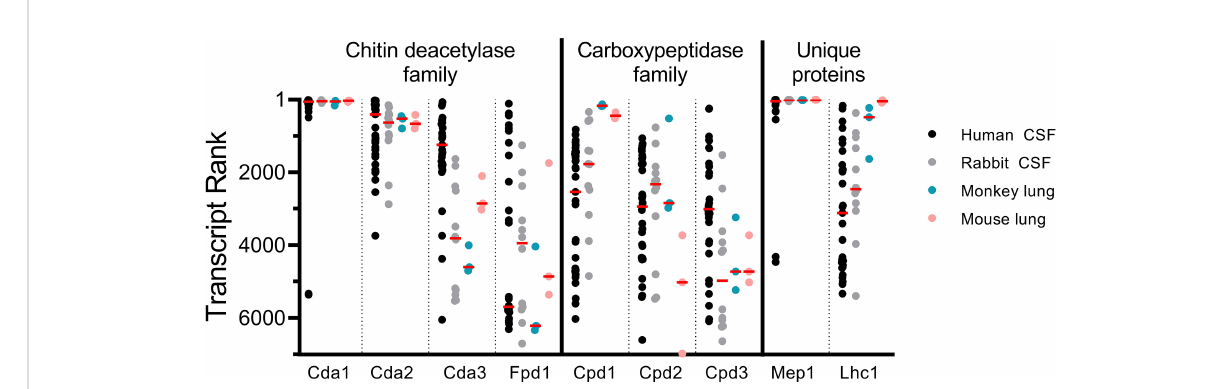
FIGURE 5 Vaccine antigen gene expression in vivo . Transcript rank is in accordance with the gene with the highest number of RNA seq reads being ranked “ 1 ” . Thus, the more abundantly transcribed genes are towards the top of the Y axis, while those with fewer transcripts are lower. RNA seq data are displayed for C. neoformans isolated from the CSF of human patients (n=33) (14, 34), the CSF of rabbits 1 day post intracisternal infection with C. neoformans clinical isolates (n=12) (34, 35), the lungs of monkeys 7 days after intratracheal infection with C. neoformans H99 (n=3) (36), and the lungs of C57BL/6 mice 7 days after intranasal infection with C. neoformans H99 (n=3) (36). Each dot represents an individual sample, except in the case of rabbit CSF, where each dot represents a pool of the CSF of 3 rabbits (n=12 pools of 3) (34, 35). Median values are denoted by the red horizontal bar. Transcripts from 6,967 genes were found in human CSF; 6,962 genes in rabbit CSF; and 6,975 genes in both monkey and mouse lungs (14, 34 –